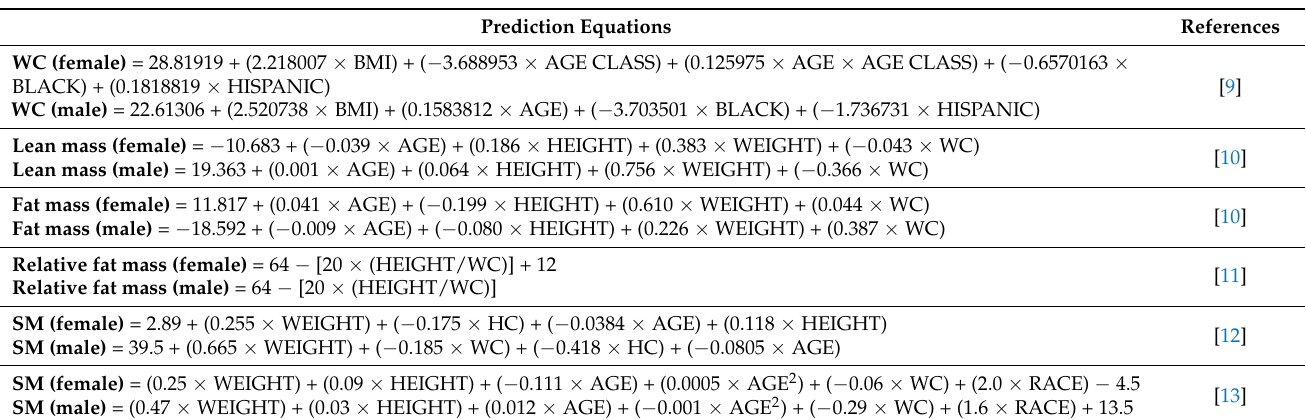
Table 1. Equations for the prediction (from anthropometric and demographic data) of waist circum- ference, lean mass, fat mass, and muscle